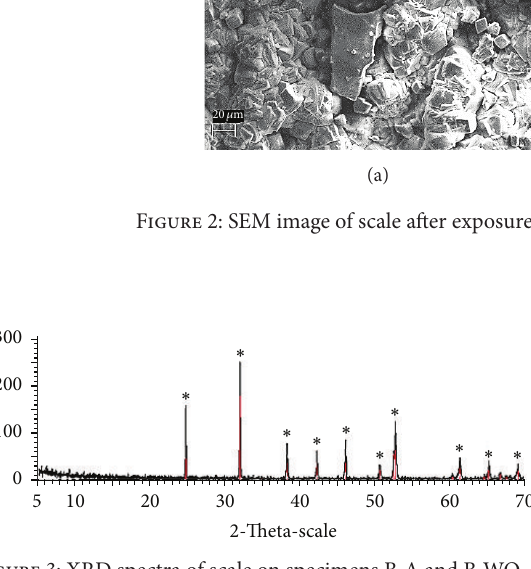
Figure 3: XRD spectra of scale on specimens B-A and